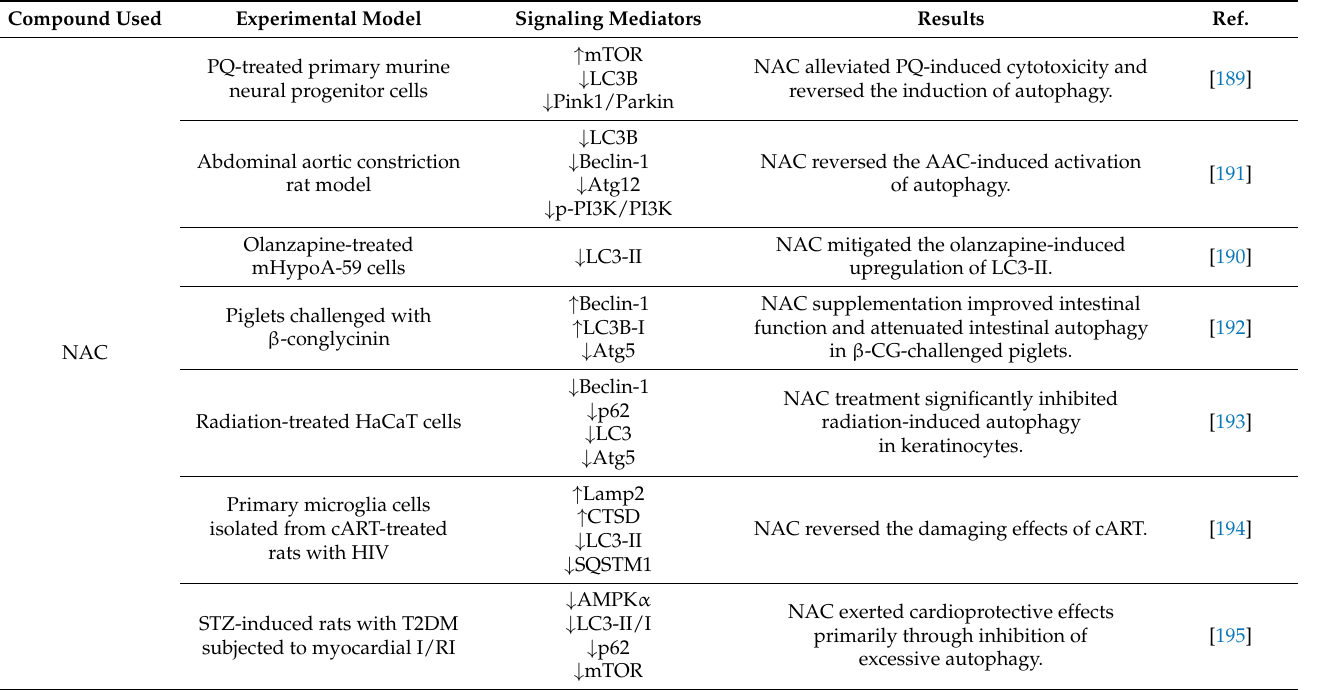
Table 8. Summary of data on the modulation of autophagy by N-acetylcysteine. Compound